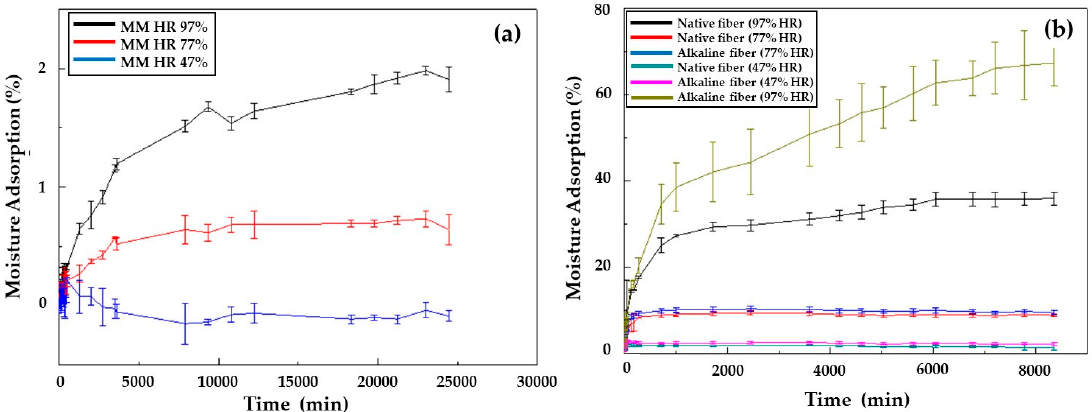
Figure 4. Adsorption isotherms at a relative humidity of 97, 77, and 47% for ( a ) Mopa-Mopa resin; ( b ) native and alkalized fique fibers.